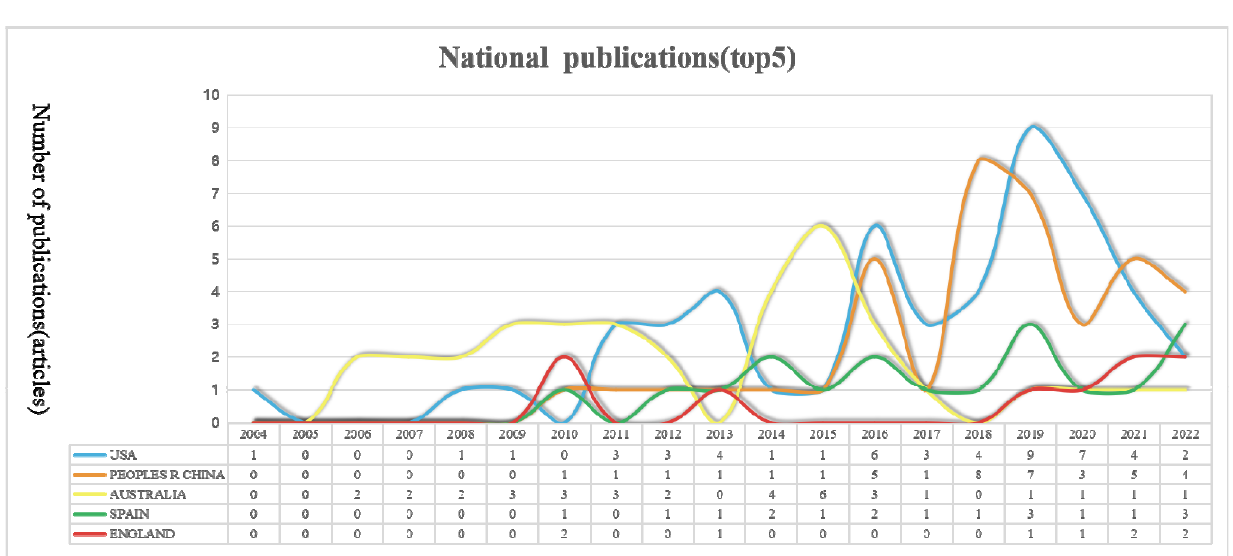
Figure 3. National publishing trends.